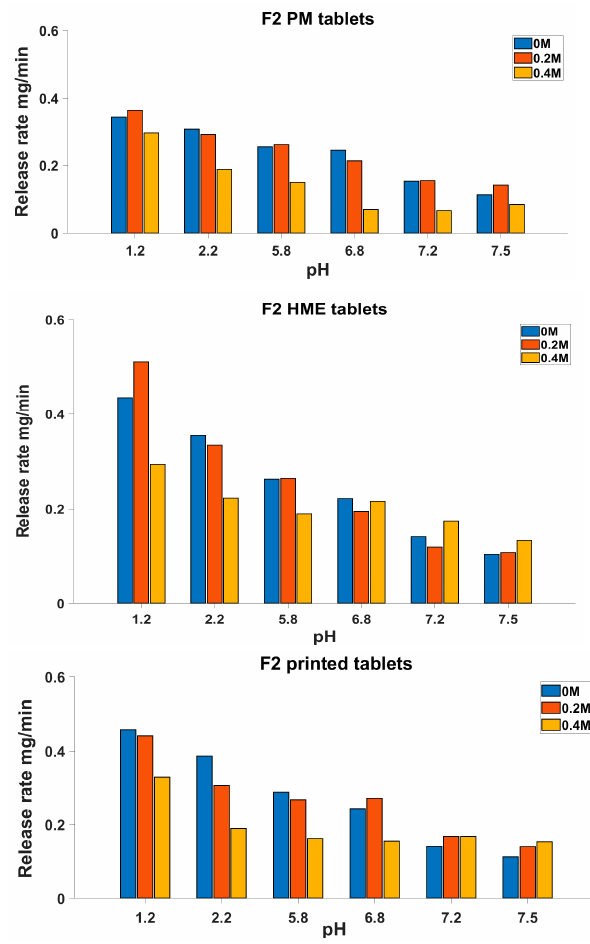
Figure 4. Release rate in each pH medium during dissolution test at different added ionic strengths for F2.